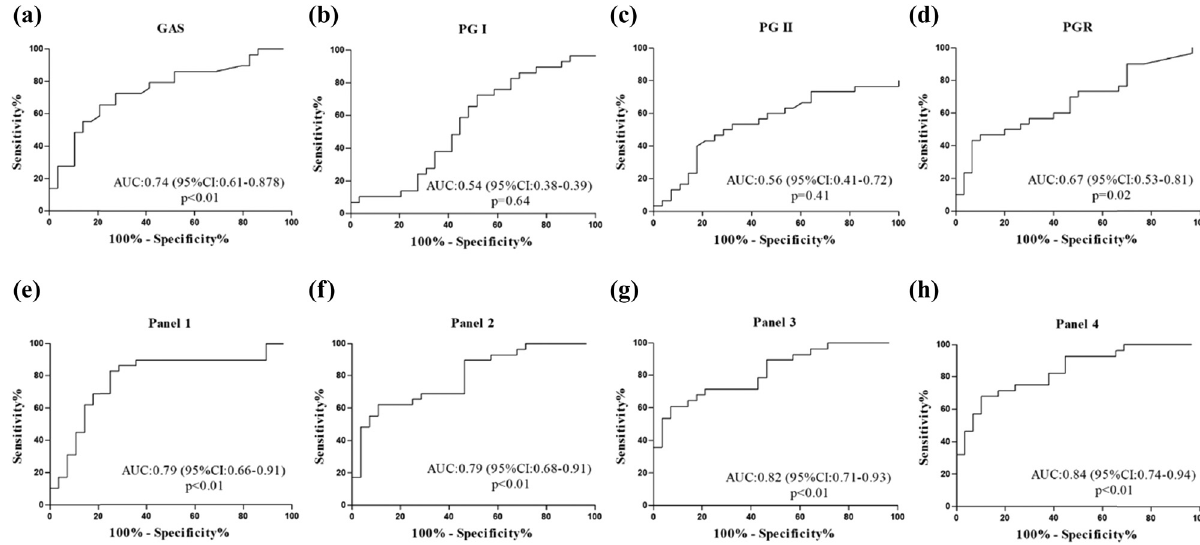
Figure 2: ROC analysis of biomarkers in CAG. ( a ) ROC analysis of GAS; ( b ) ROC analysis of PG - I. ( c ) ROC analysis of PG - II. ( d ) ROC analysis of PGR. ( e ) ROCanalysisofPanel1 ( combinationofGAS,PG - I,andPG - II ) . ( f ) ROCanalysisofPanel2 ( combinationofGAS,PG - I,PG - II,andPGR ) . ( g ) ROCanalysis of Panel 3 ( combination of GAS, PG - I, PG - II, PGR, and hsa - miR - 122 - 5p ) . ( h ) ROC analysis of Panel 4 ( combination of GAS, PGR, and hsa - miR - 122 - 5p ) .